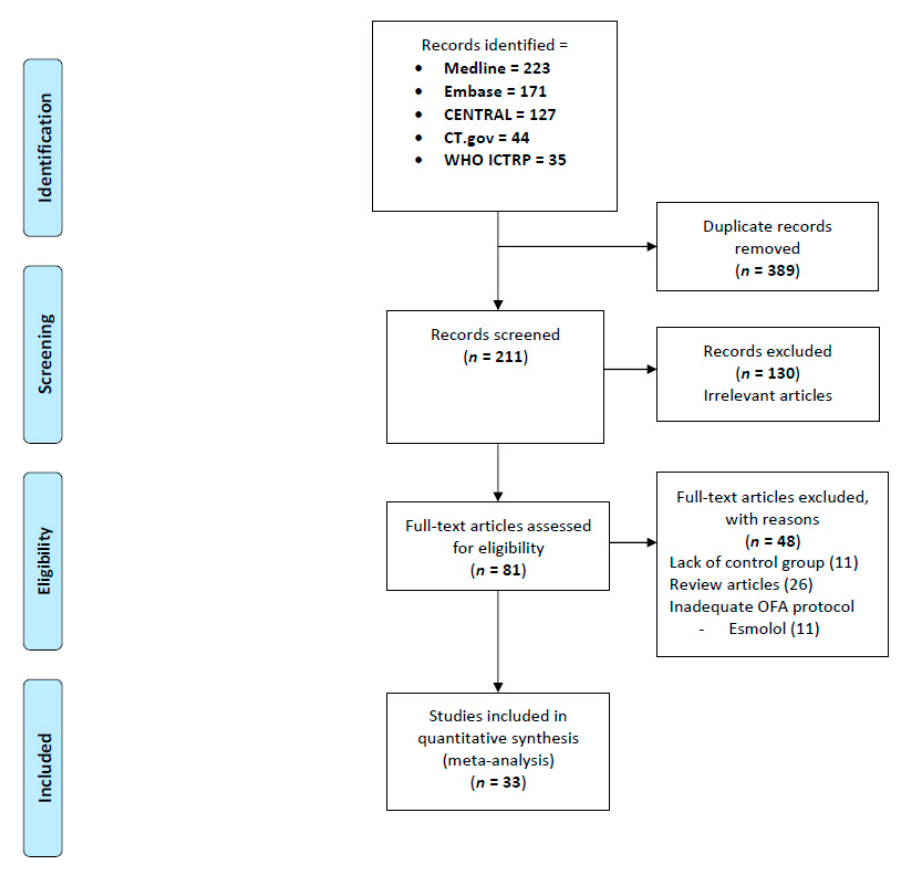
Figure 1. PRISMA flow chart detailing retrieved, excluded, assessed, and included trials.